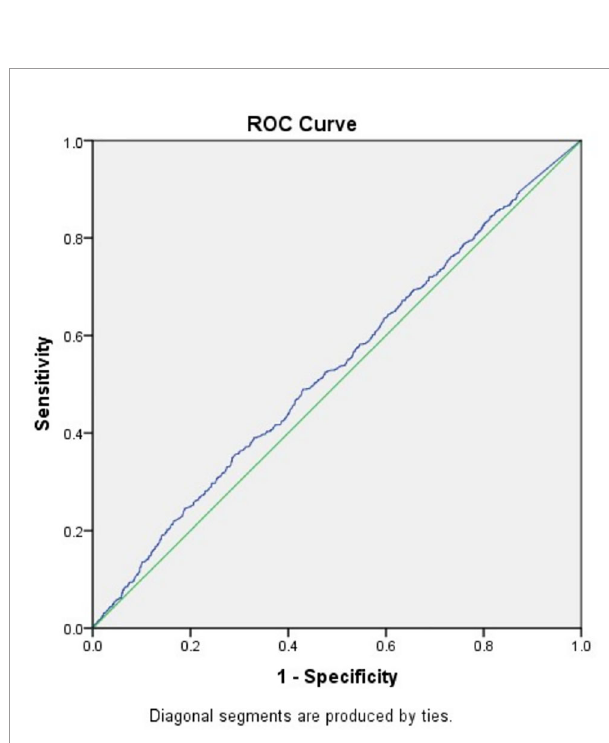
FIGURE 2 | Receiver-operating characteristic (ROC) curve analysis for AMH as a predictor of CPR.